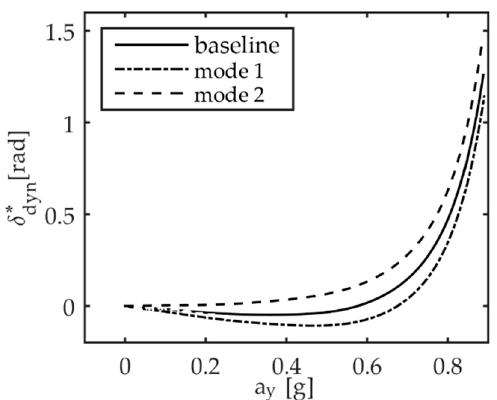
Figure 8. Desired understeering behaviour for vehicle 2 in mode 1 and mode 2.